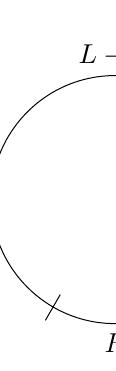
Figure 2 . A ring (with circumference L ) with two branes (perpendicular lines) separated by R . For “transparent” branes one expects the frequencies to obey m = 2 πn boundary conditions at the branes, one expects m = πn are the limiting cases of (2.5) for m (cid:28) r − 1